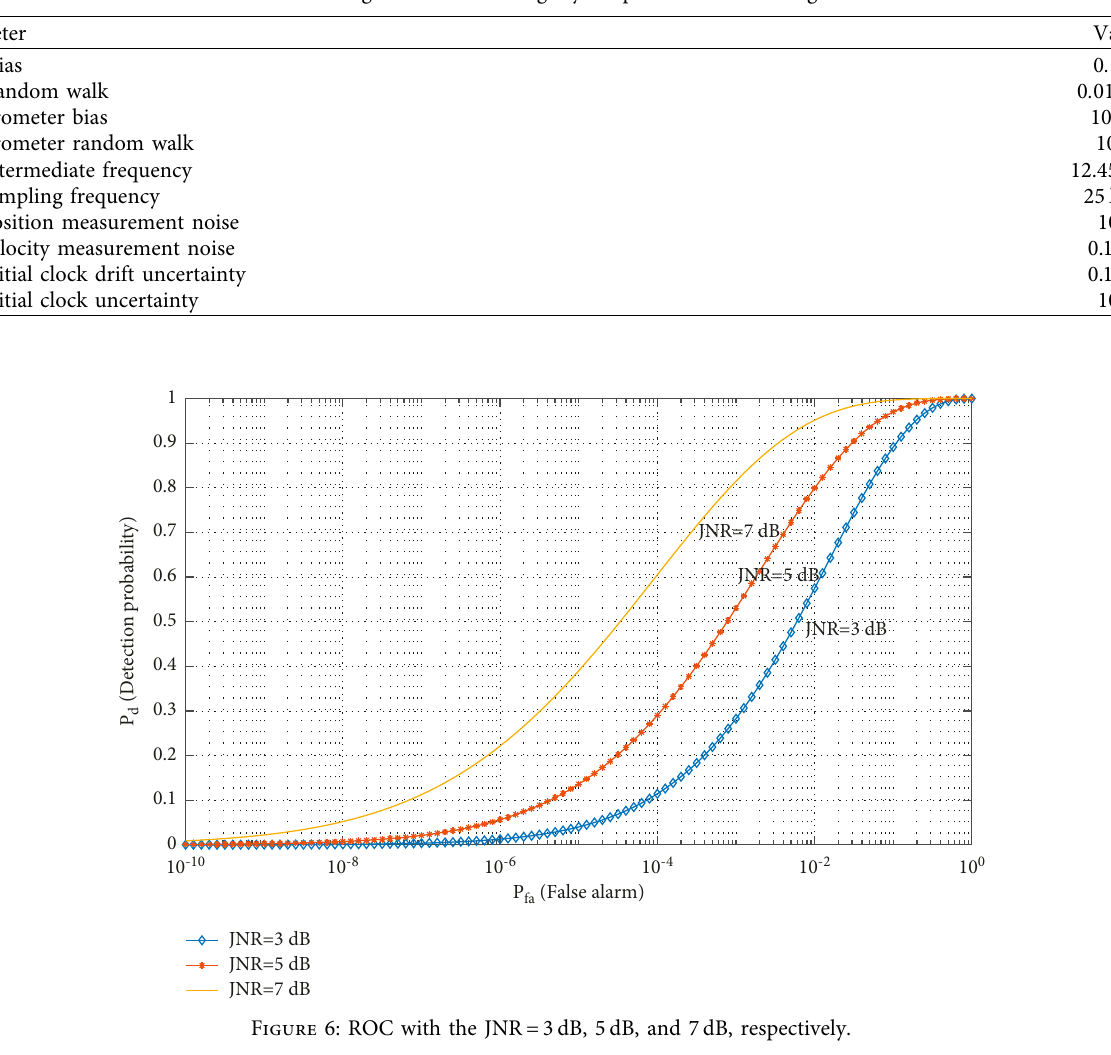
Figure 5: Trajectory of the vehicle for 60seconds in NED frame. Table 2: Configurations for the tightly coupled INS/GNSS integration.